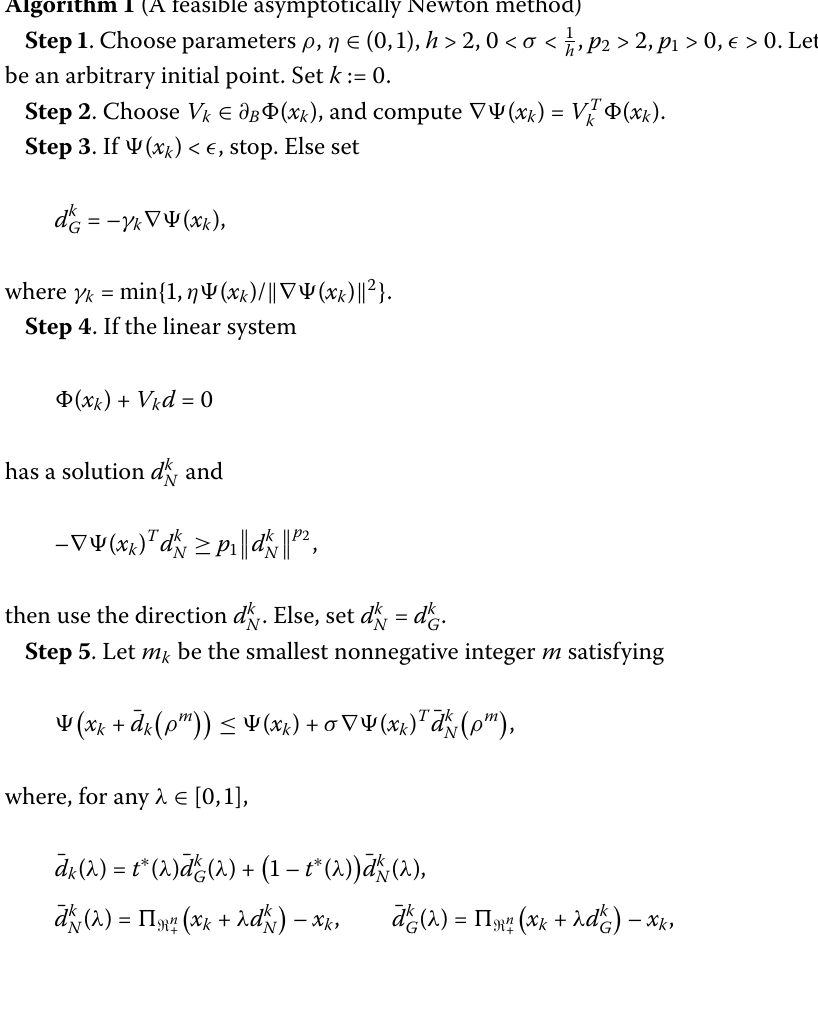
Algorithm  (A feasible asymptotically Newton